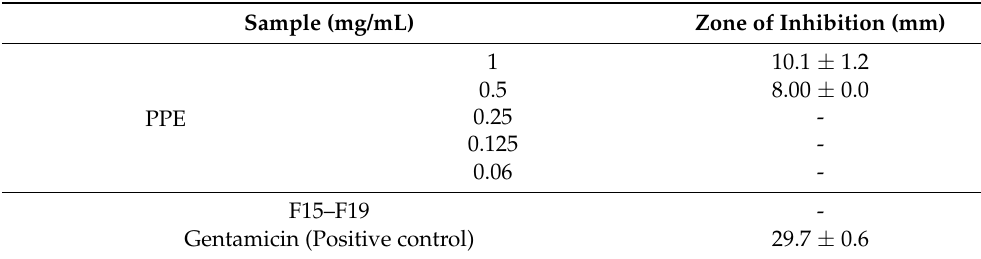
Table 4. Zone of inhibition (mm) against Staphylococcus aureus for PPE, n = 3. Sample